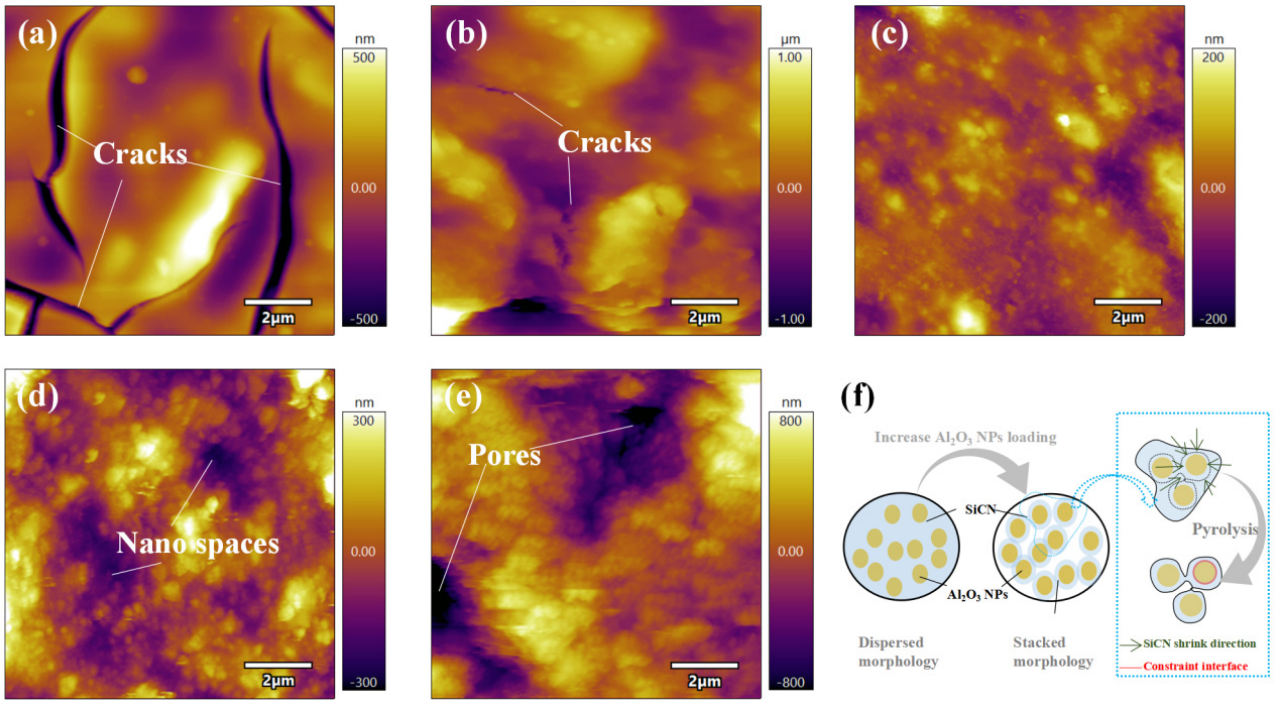
Figure 3. AFM images of ( a ) SiCN, ( b ) Al 2 O 3 (10 wt%)/SiCN, ( c ) Al 2 O 3 (20 wt%)/SiCN, ( d ) Al 2 O 3 (30 wt%)/SiCN, and ( e ) Al 2 O 3 (40 wt%)/SiCN. ( f ) Schematic illustration of the microstructure evolution of the Al 2 O 3 /SiCN film with increasing Al 2 O 3 NP loading.